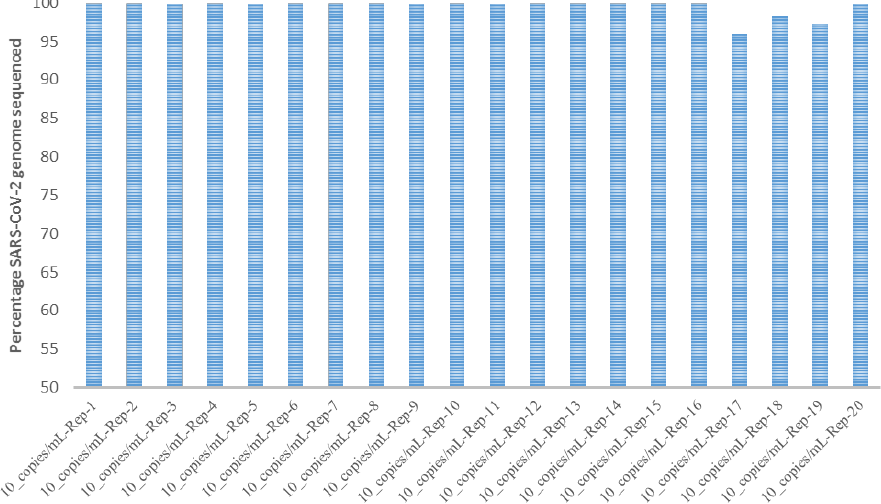
Figure 3. Reproducibility study using 10 copies/mL.